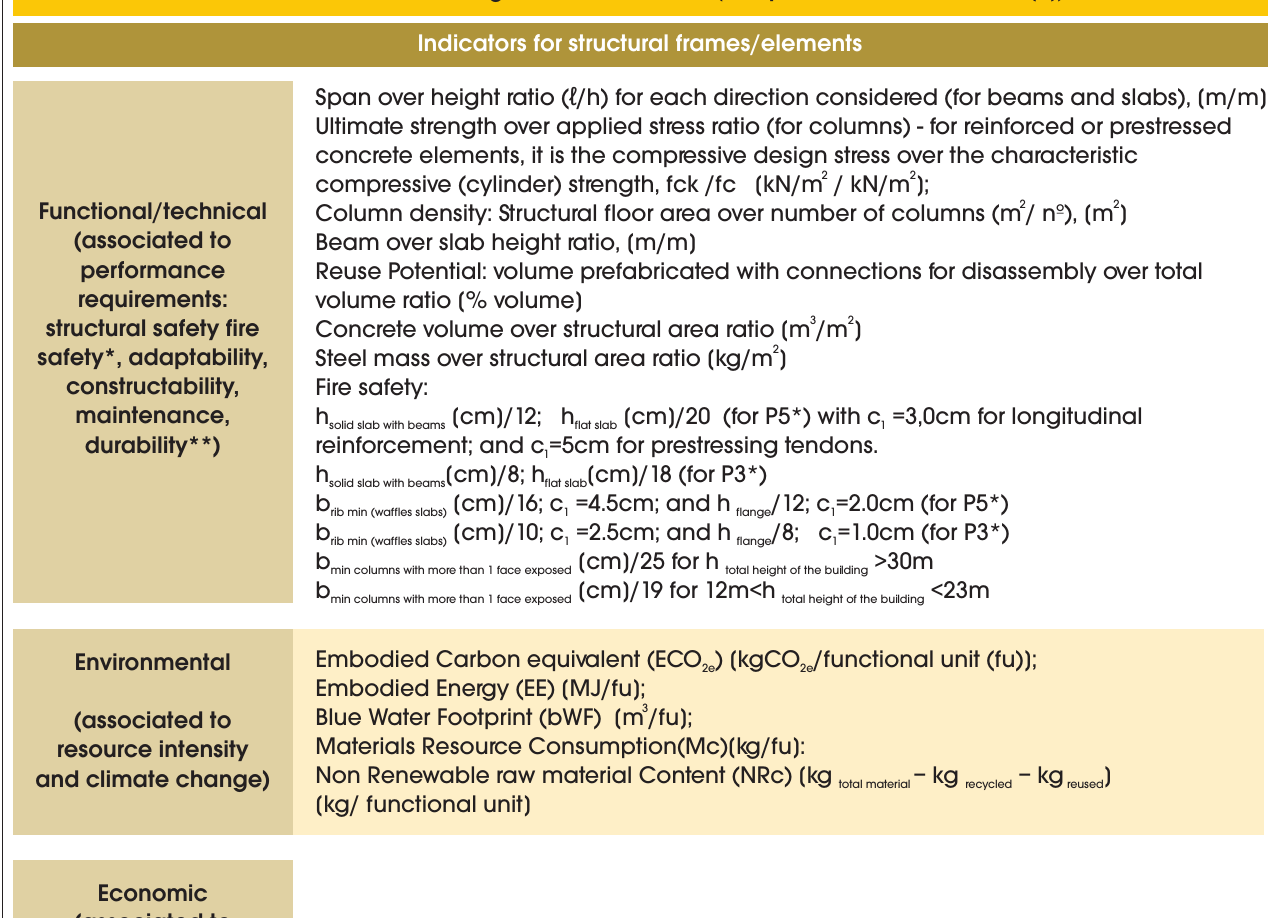
Table 1 – Functional/technical, environmental and economic indicators